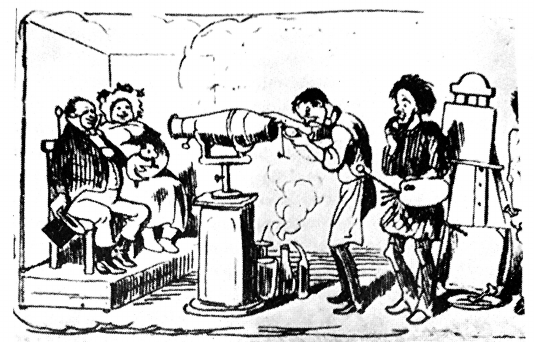
Figure 3. The Unhappy Painter , by Theodor Hosemann, 1843, satirizes the painter, a victim of progress, made obsolete by a daguerreotype. Public domain